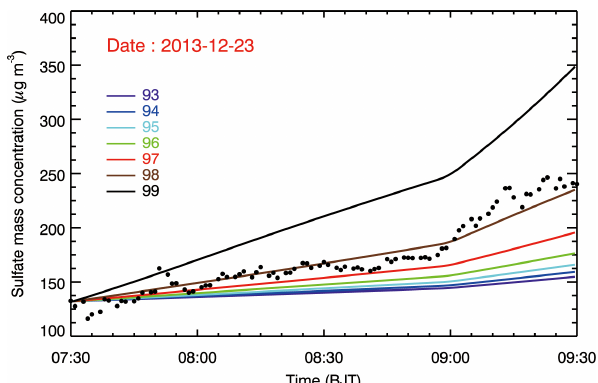
Figure 6. Sulfate growth simulated by the box model with the HRSO 2 parameterization under various relative humidity condi- tions at IEECAS site in Xi’an from 07:30 to 09:30BJT on 23 De- cember 2013. The black dots denote the HR-ToF-AMS measure- ment and the solid lines with different colors represent the box model simulations under different relative